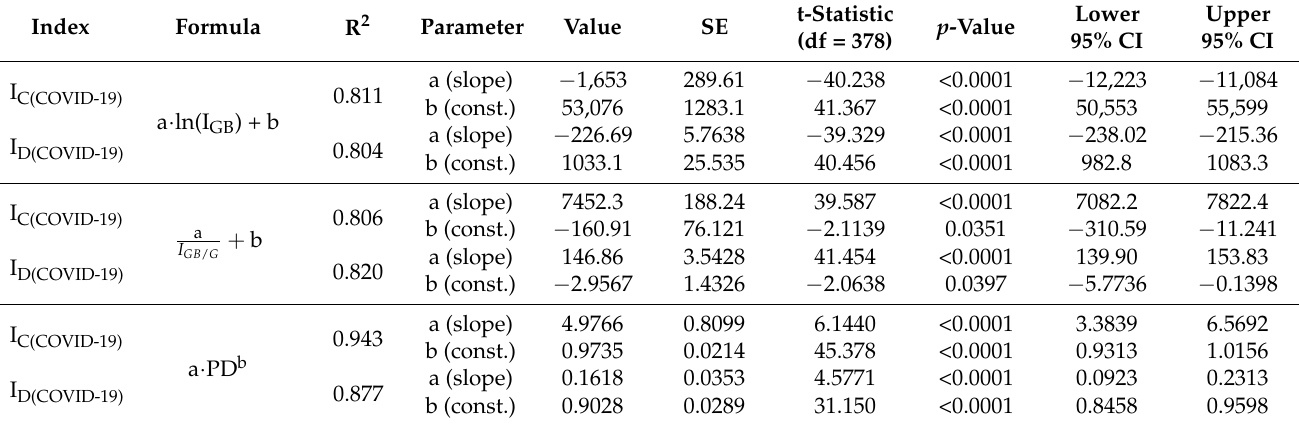
Table 1. Results of the regression analysis between the green-blue spaces index (I GB in %), green-blue/grey index (I GB/G , − ), and population density (PD in people per 1 km 2 ) and index of the total number of COVID-19 cases (I index of the total number of COVID-19 deaths (I D(COVID-19) ) in the counties of Poland ( N = 380); in relation to Figure